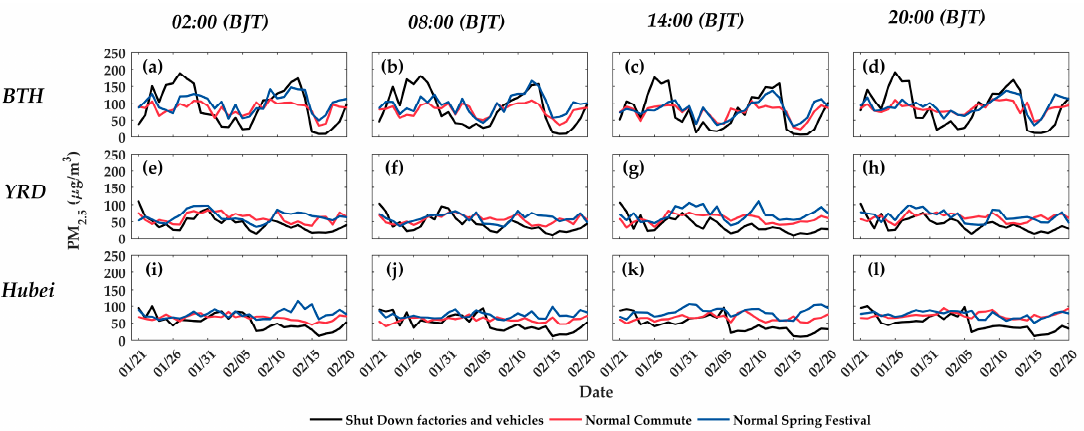
Figure 3. Temporal trend of the observed or predicted PM 2.5 concentration during the period of the shut down of factories and vehicles under different emission scenarios. The black, red, and blue lines represent the PM 2.5 concentration under shutting down factories and vehicles (SD), normal commute (NC), and spring festival (NSF), respectively. ( a–l ) represent the results of BTH, YRD, and Hubei at 02:00, 08:00, 14:00, and 20:00 (BJT), respectively.